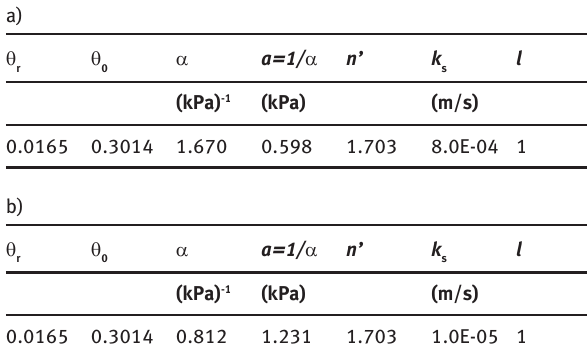
Figure 10: Conductivity functions